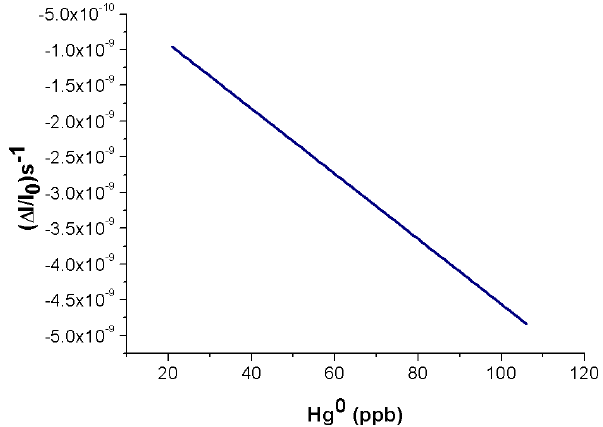
Figure 10. Linear relationships between the normalized response time and the Hg 0 concentration within the range of 20 and 100ppb v